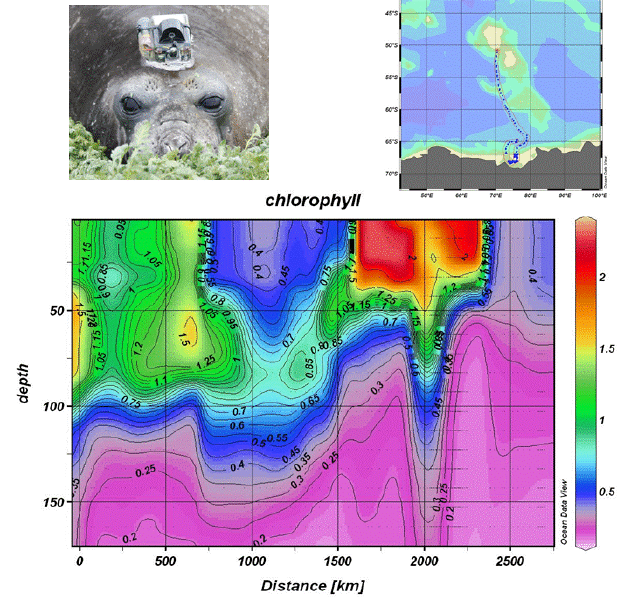
Figure 7. Top: female SES equipped with a CTD-FLUO-SRDL and section to the track followed by a juvenile SES female between January–April 2009. This female left Kerguelen on 12 January and reached the Antarctic shelf on 6 February. This female left the Antarctic shelf on 14 March, the female then remained associated with the marginal ice zone and the Antarctic divergence. Bottom: interpolated quenching corrected fluorescence profiles provided by this SES along its track. This tag exhibited a fluorescence o ff set of 0.2 µ gL − 1 of chl a and Antarctic values higher than 2 µ gL − 1 were saturated. The abrupt change in chl a concentration (km 2400) coin- cides with sea-ice formation which took place in mid march. These data show both the latitudinal change in the phytoplankton concen- tration along a north south transect performed during the inward trip (i.e., 1600km south of Kerguelen 500m isobath) and the transition in phytoplankton concentration in Antarctic waters from summer to fall (from km 1600 to